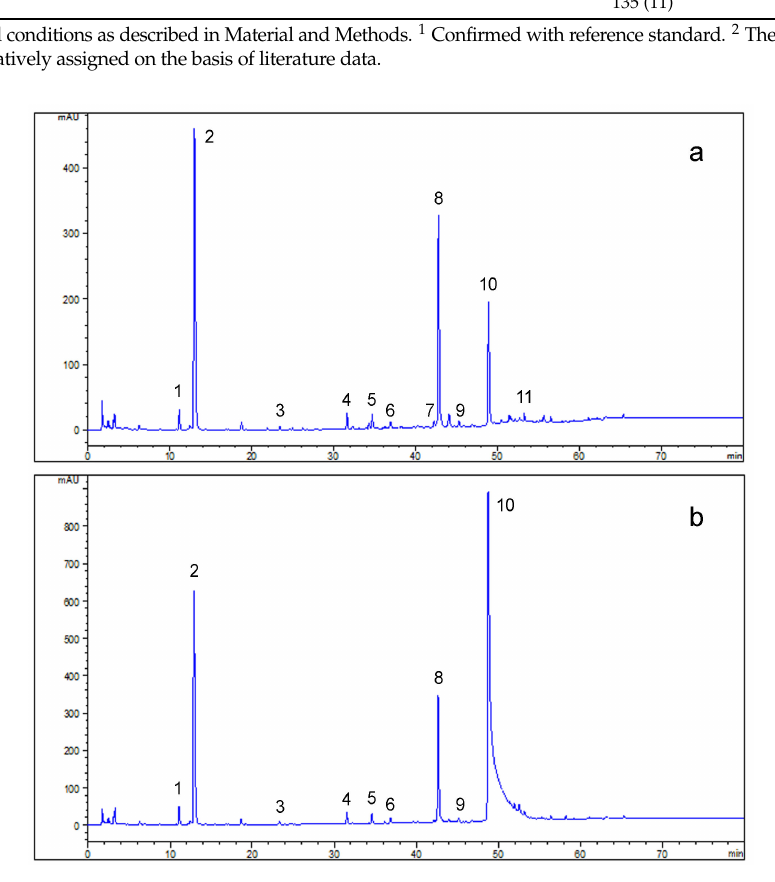
Figure 3. Chromatogram acquired by HPLC-UV/DAD analysis of the onion water extract at 254 nm before ( a ) and after ( b ) the first dyeing cycle. For peak identification, see Table